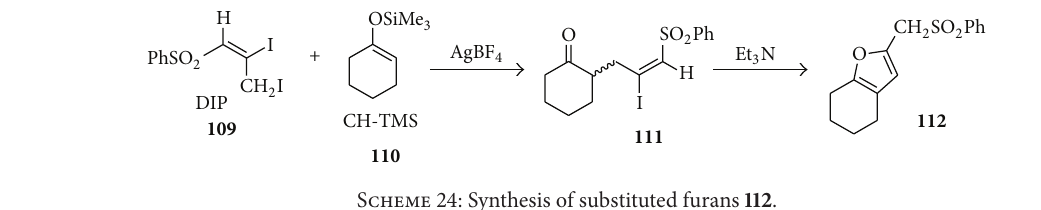
Scheme 24: Synthesis of substituted furans 112 .